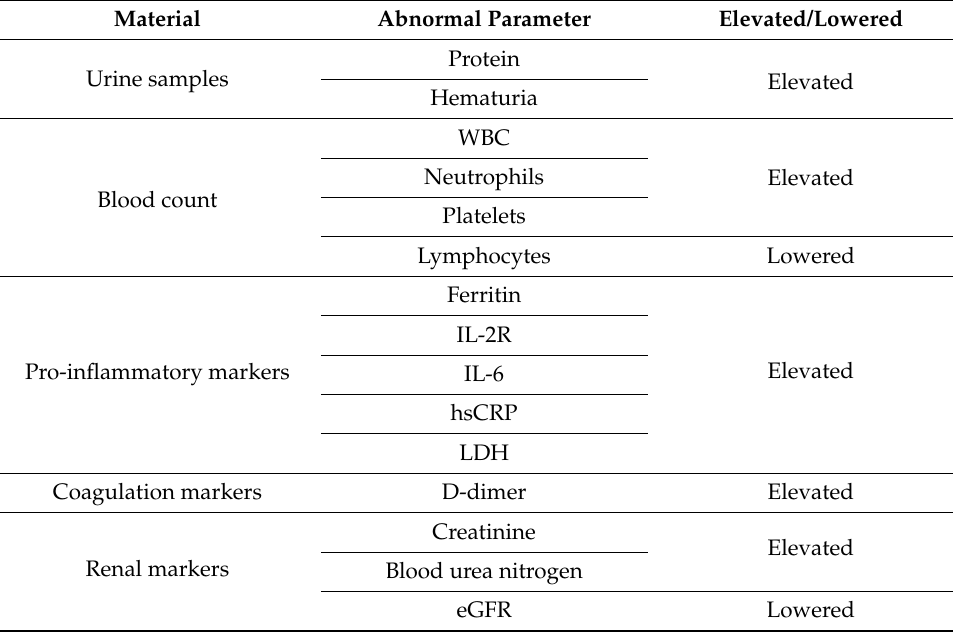
Table 3. Laboratory findings on patients with COVID-related